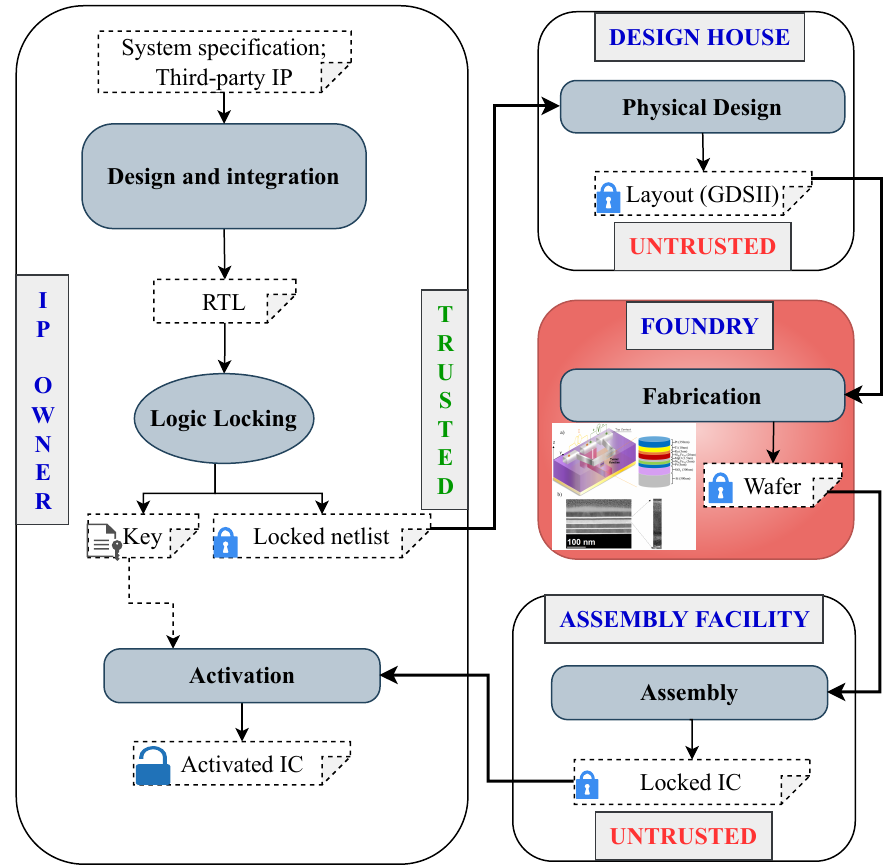
Figure 1. Overall Logic Locking mechanism in SoC design flow with trusted and untrusted